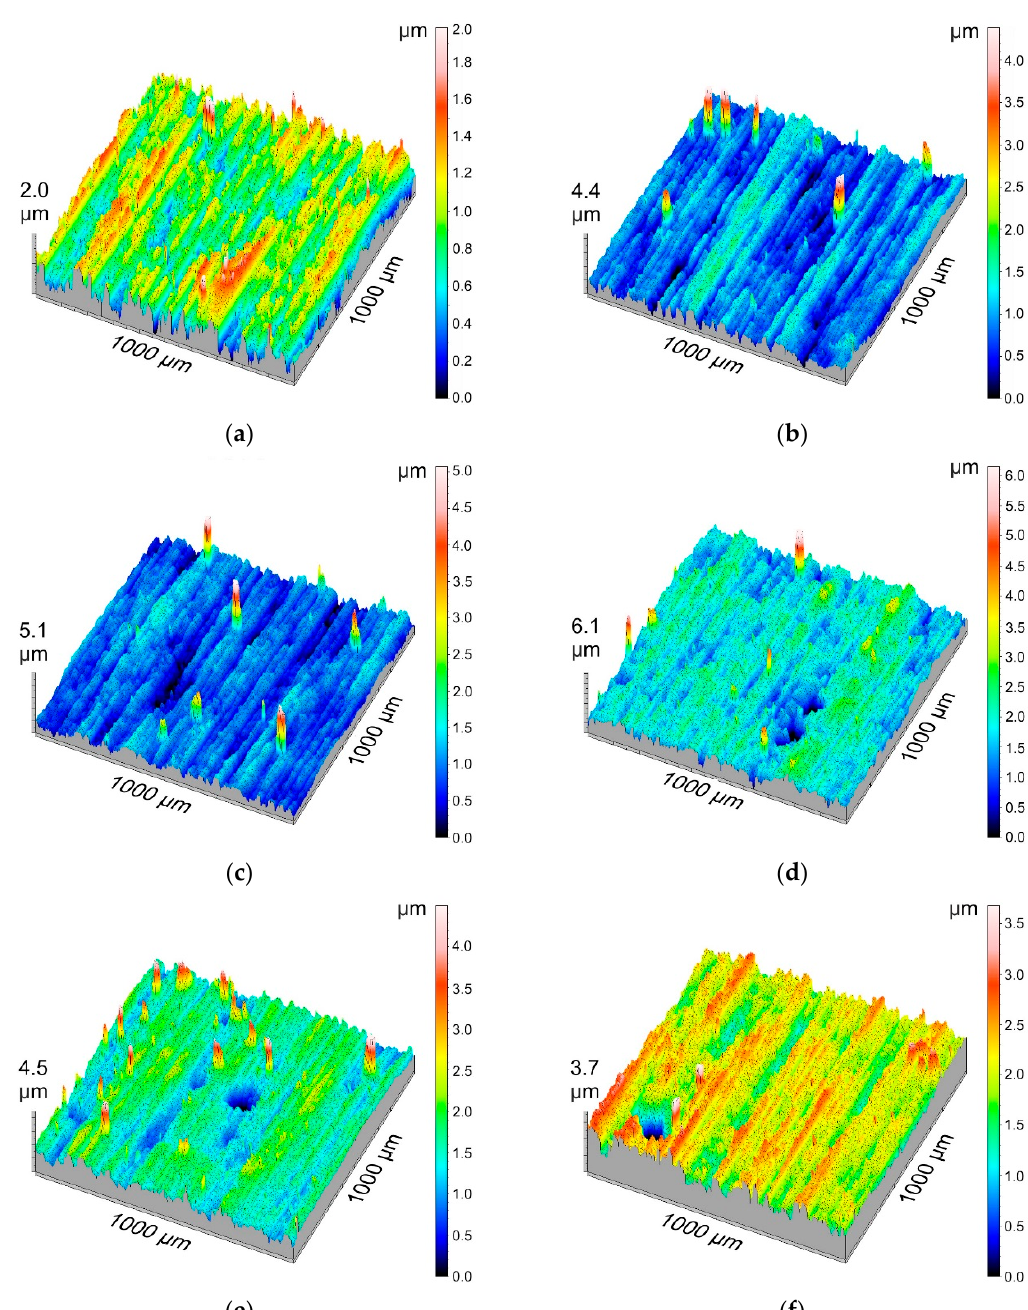
Figure 2. Top view of oxide layer surfaces (3D) (designations of samples in Table 1).